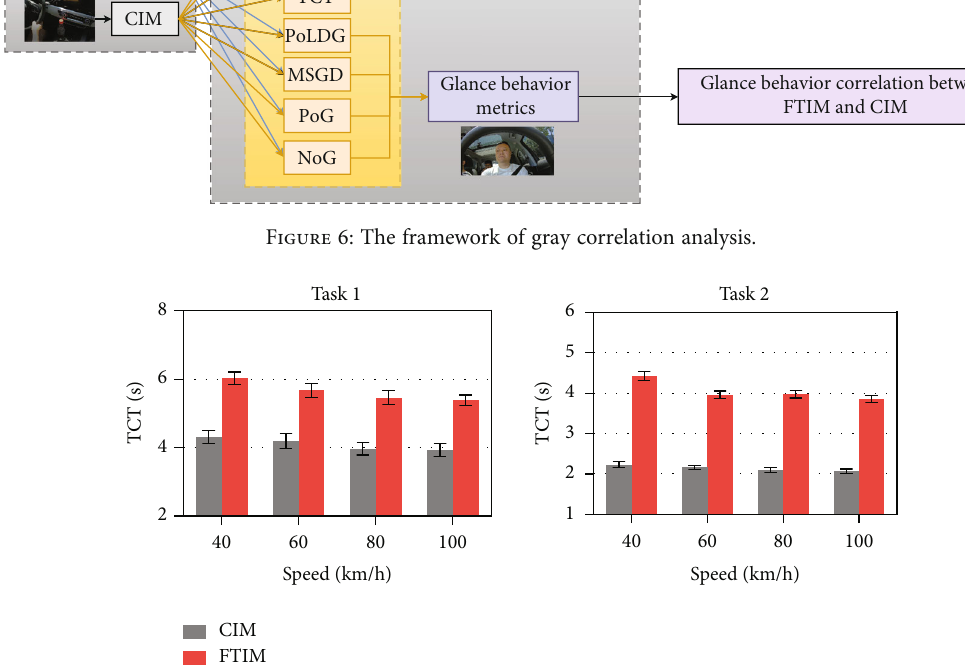
Figure 7: TCT for two tasks by interaction mode and vehicle